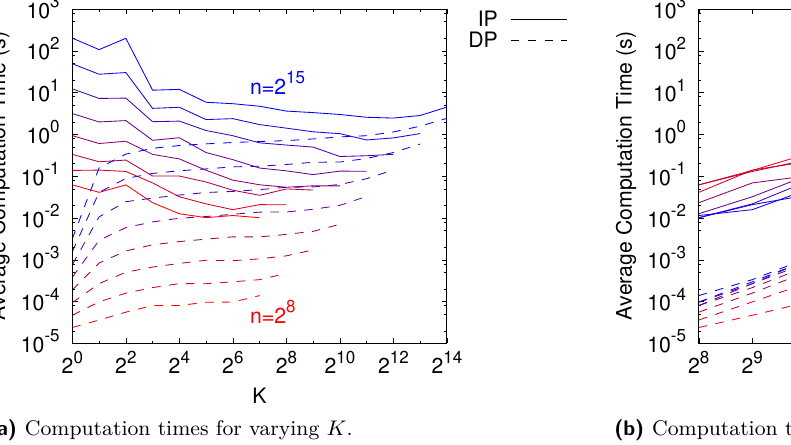
Figure 2 Experiment 1: Computation